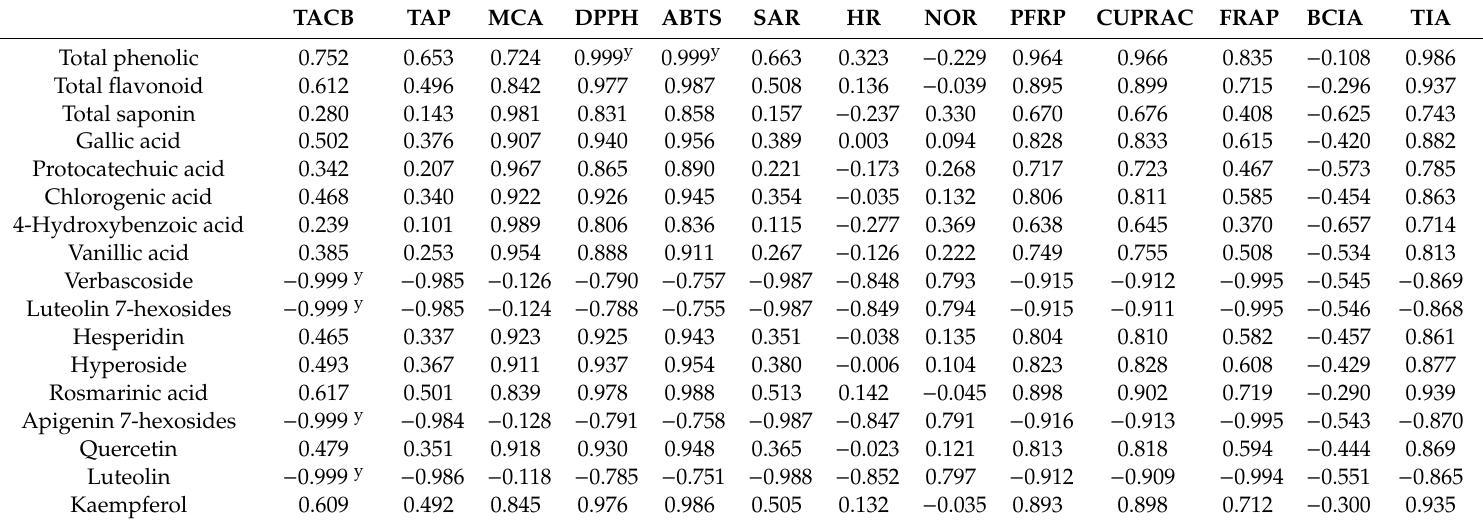
Table 7. Correlation coe ffi cients between the assays x